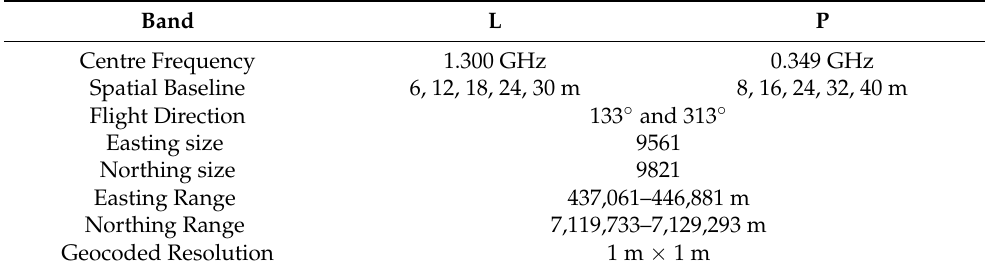
Table 1. Characteristics of PolInSAR